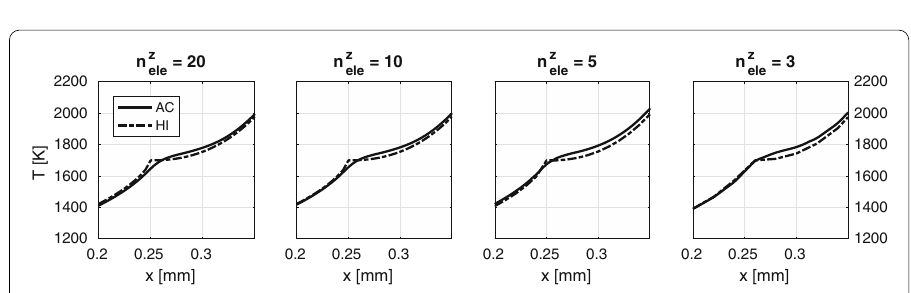
Fig. 18 Surface temperature profiles for AC and HI along laser path (i.e. y = 0 . 0mm) for different spatial discretizations. Zoomed in to solidification region in melt pool tail